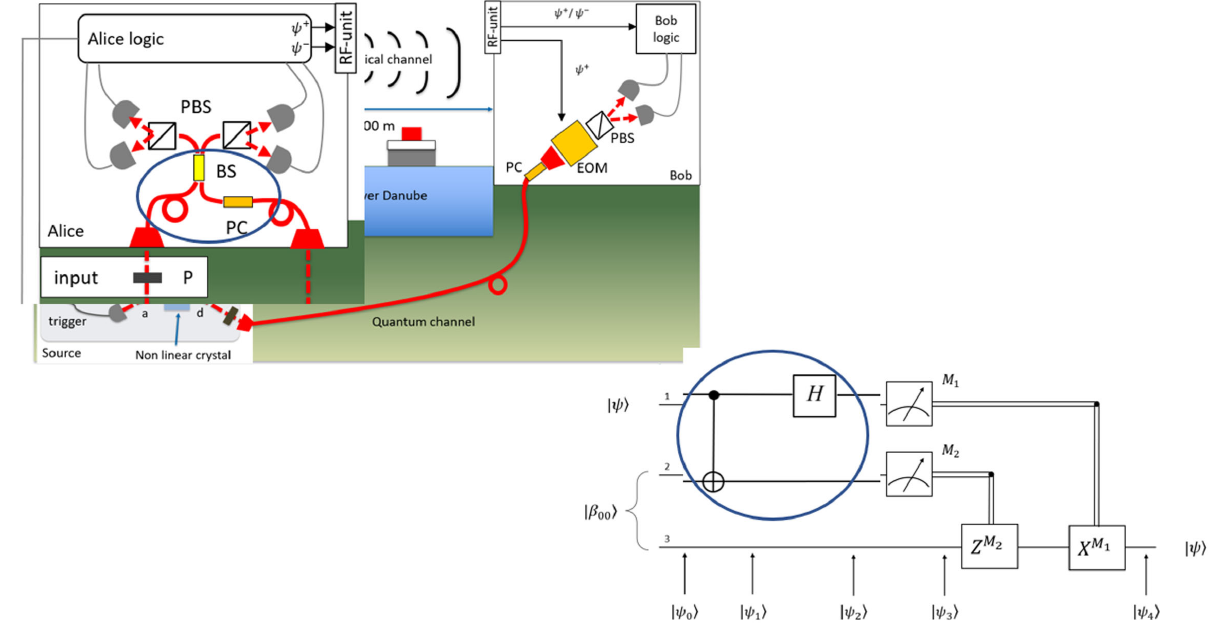
FIG. 14. Comparison between the “ experimental and computational ” projection of two photons in a Bell state.